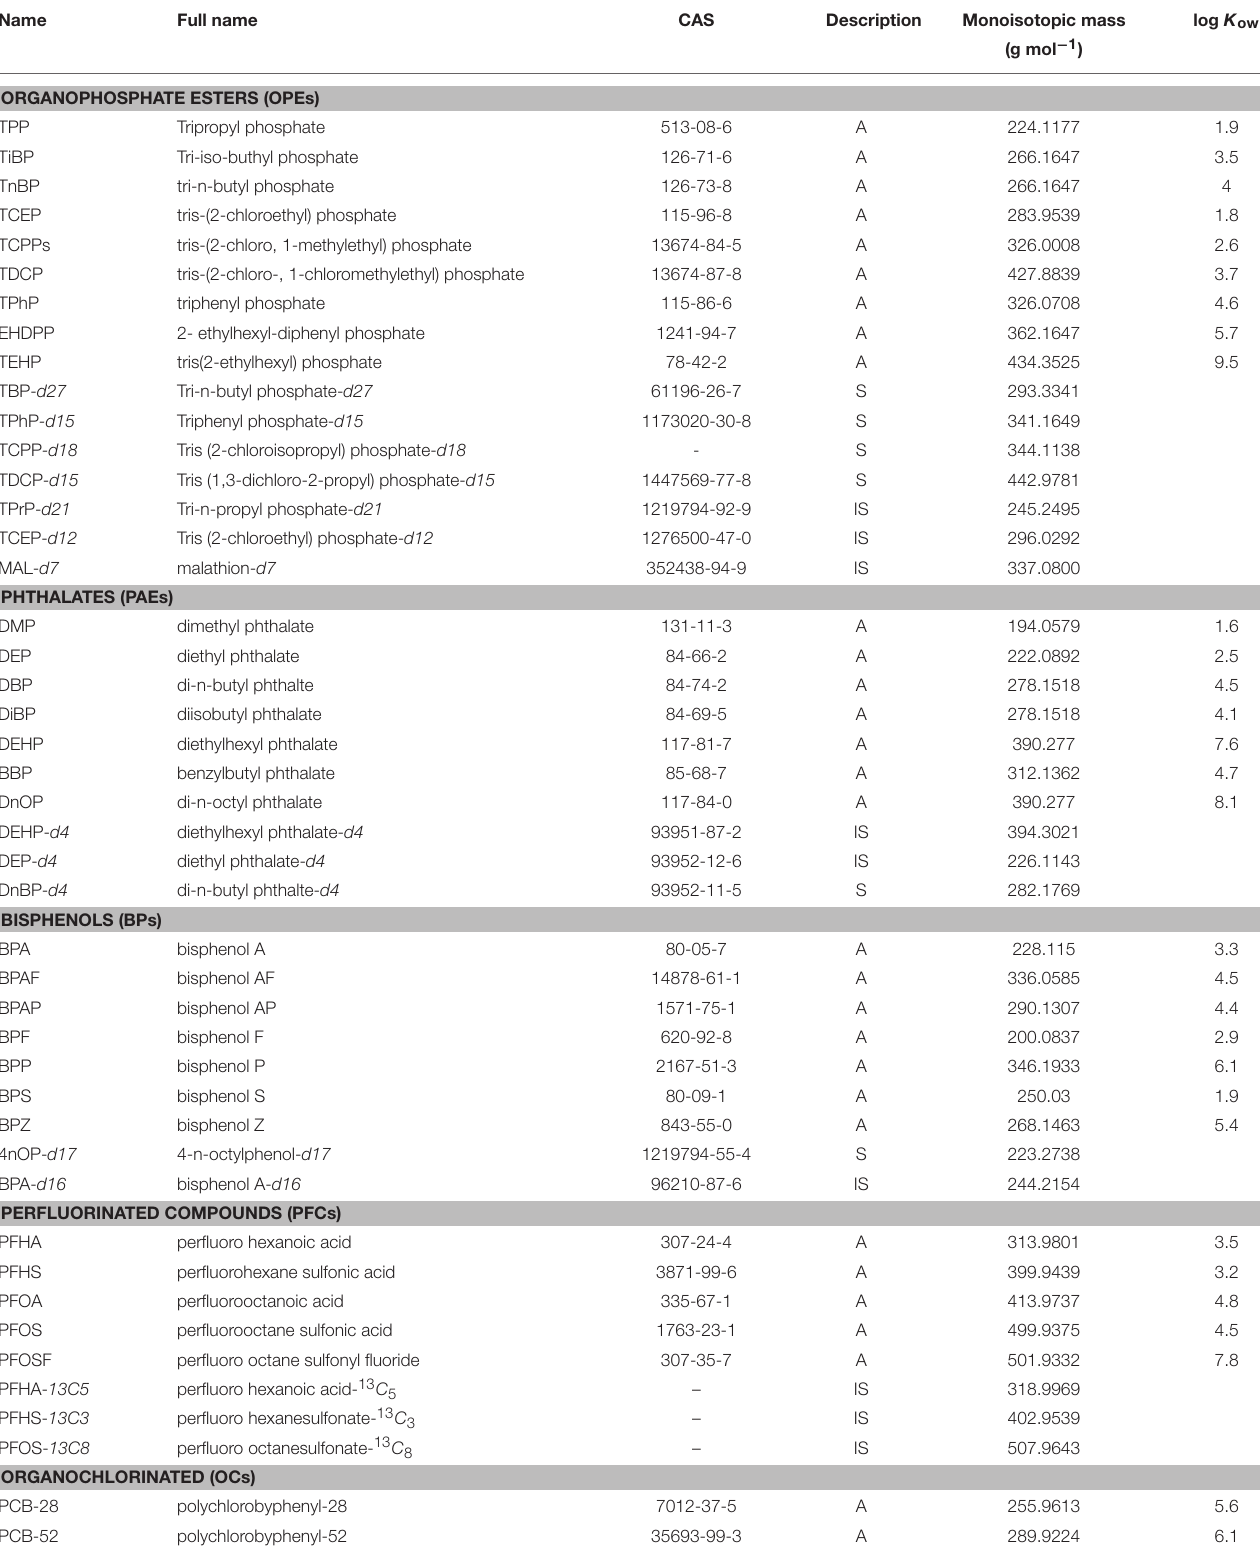
TABLE 1 | Identification and physico-chemical properties of target